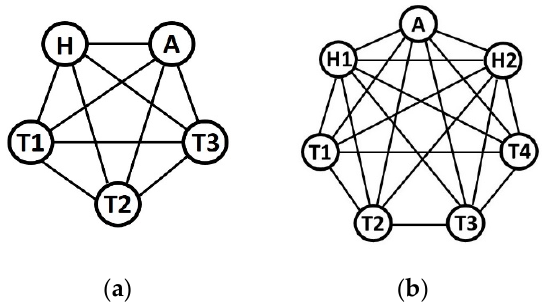
Figure 7. ( a ) Smart apartment, with one tenant; ( b ) smart apartment with two